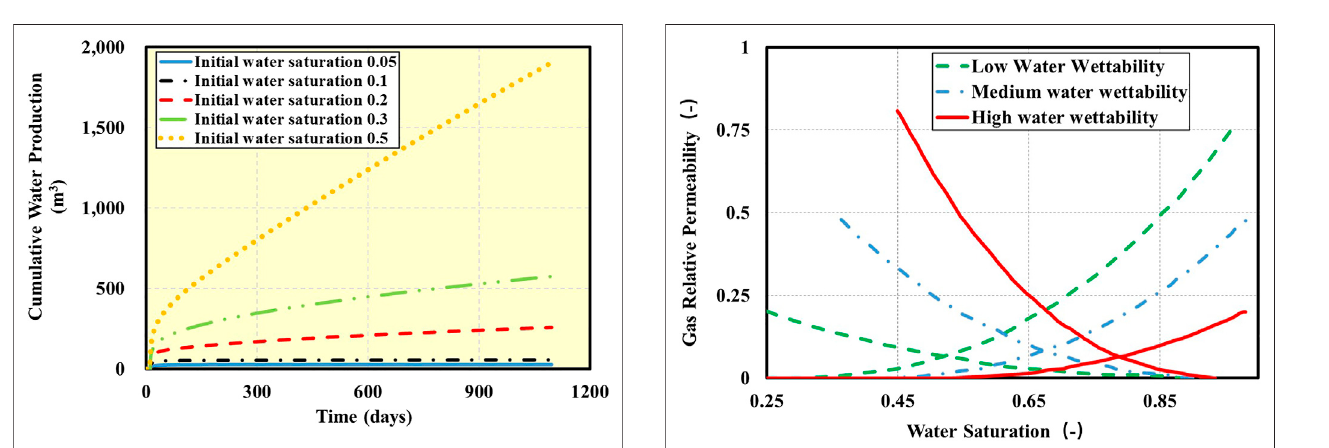
FIGURE8| Relative permeability curvesfordifferentwettability degrees.